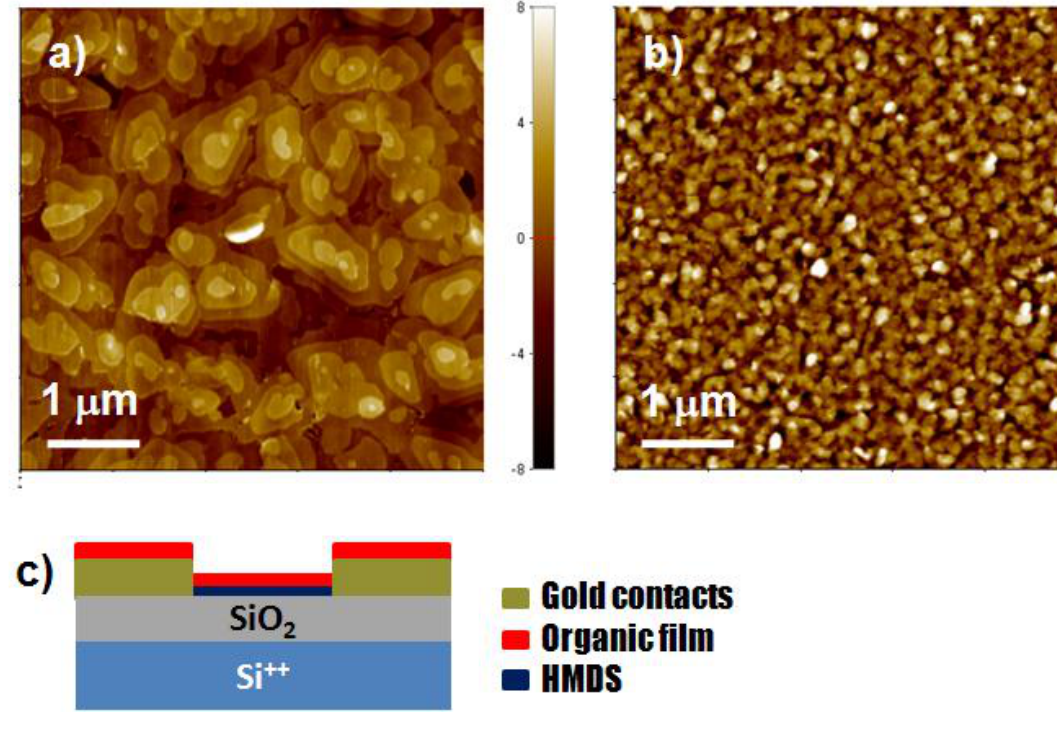
Figure 1. Atomic force microscopy (AFM) images (size 5 × 5 µm 2 ) of PDIF-CN grown on ( a ) Hexamethyldisilazane (HMDS)-treated and ( b ) bare SiO bottom panel ( c ), we report a transversal sketch of the